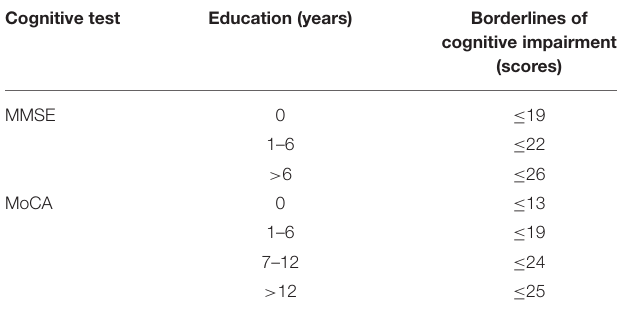
TABLE 1 | The cutoffs of cognitive impairment for all